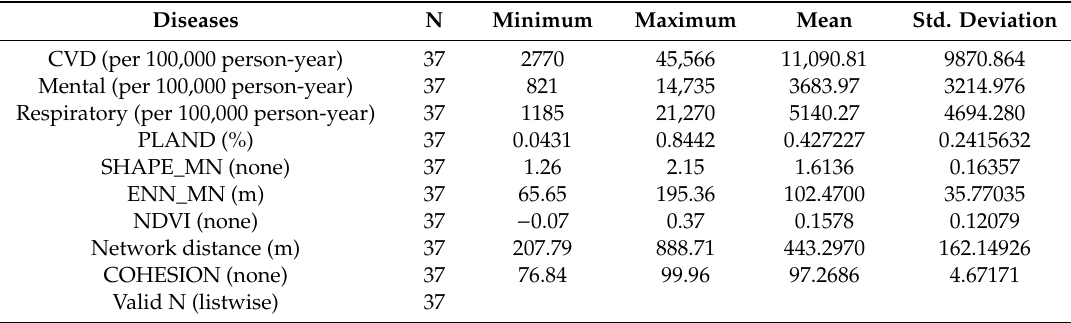
Table 2. Descriptive statistics of the studied variables.